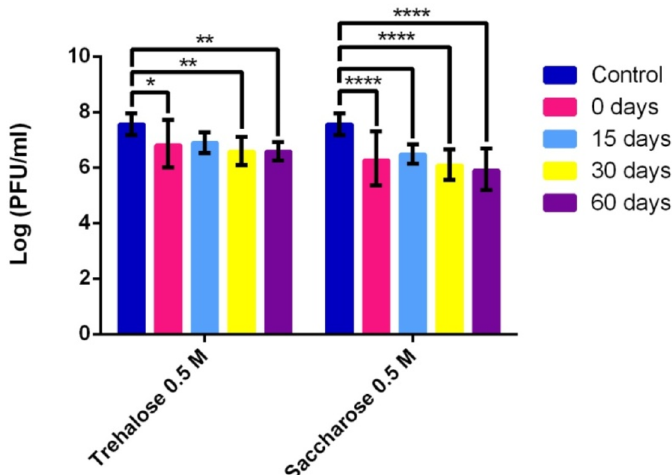
Figure 2. Stability of phage vRsoP-WF2 lyophilized with trehalose or saccharose at 0.5 M and stored at 4 ◦ C over time. Titration was carried out by the double layer agar method on CPG plates. Data are the means for assays performed at least in triplicate, and error bars indicate variation as the standard deviation. Asterisks above bars denote statistically significant differences between the two signaled columns: * p < 0.05, ** p < 0.01, **** p < 0.0001.